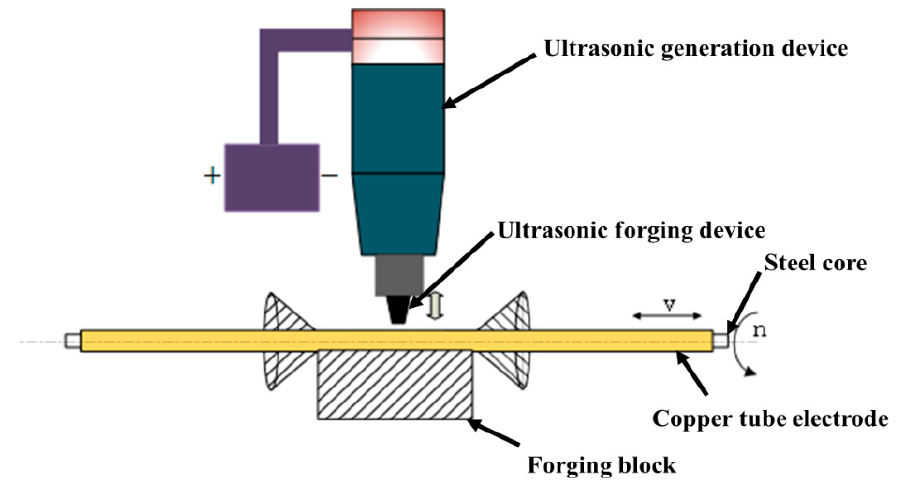
Figure 4. Principle diagram of ultrasonic high-frequency percussion fabrication of ultra-fine and ultra-long copper tube electrodes.